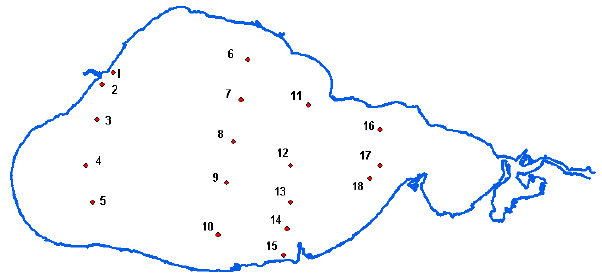
Figure 2: Turbidity and chlorophyll a sampling